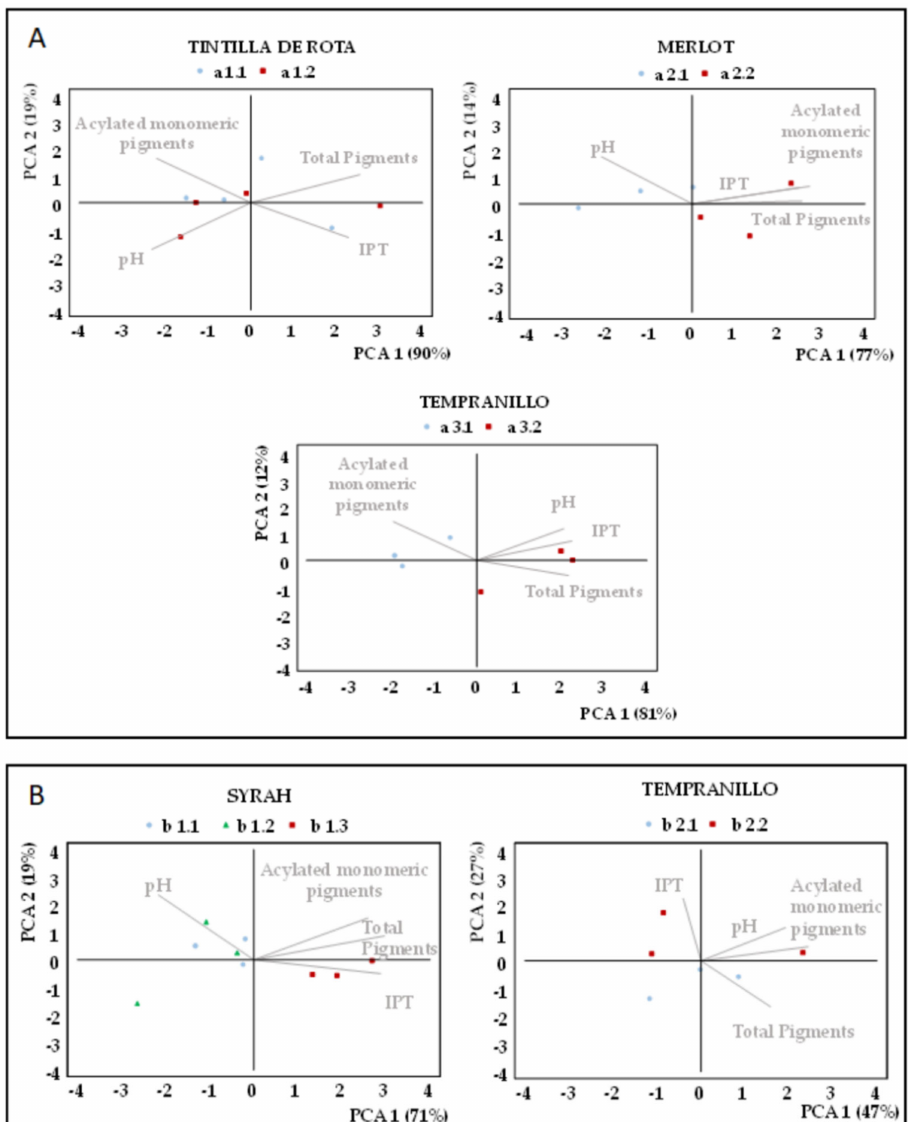
Figure 5. Principal Component Analysis for total and acylated monomeric pigments, total polyphe- nols index and pH in different varieties of grapes. The image shows ( A ) the use of elicitors and ( B ) canopy management